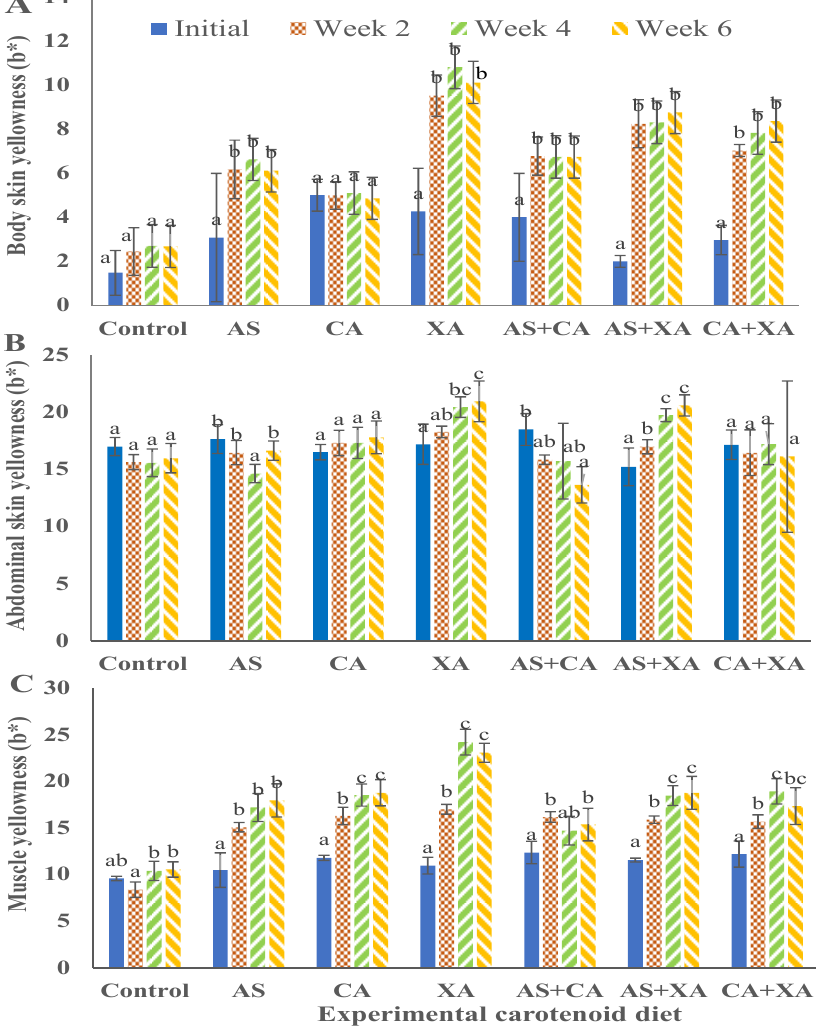
Figure 6. Yellowness (b*) value for body skin ( A ), abdominal skin ( B ), and muscle ( C ) of bighead catfish fed dietary pigments for 2, 4, and 6 weeks. Astaxanthin (As), canthaxanthin (Ca), and xanthophyll (Xa). (a, b, c) Average values of different diets at the same sampling time with different letters are significantly different ( p < 0.05). Each bar is the mean value of three replicates, three fish per replicate.